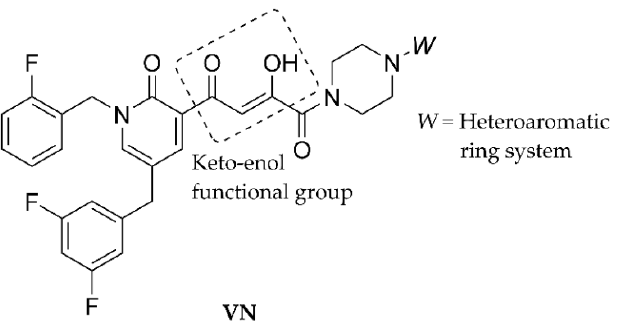
Figure 3. General structure of highly lipophilic anti-MDR-TB compounds (series VN ) containing a keto-enol functional group as a part of their connecting chain.